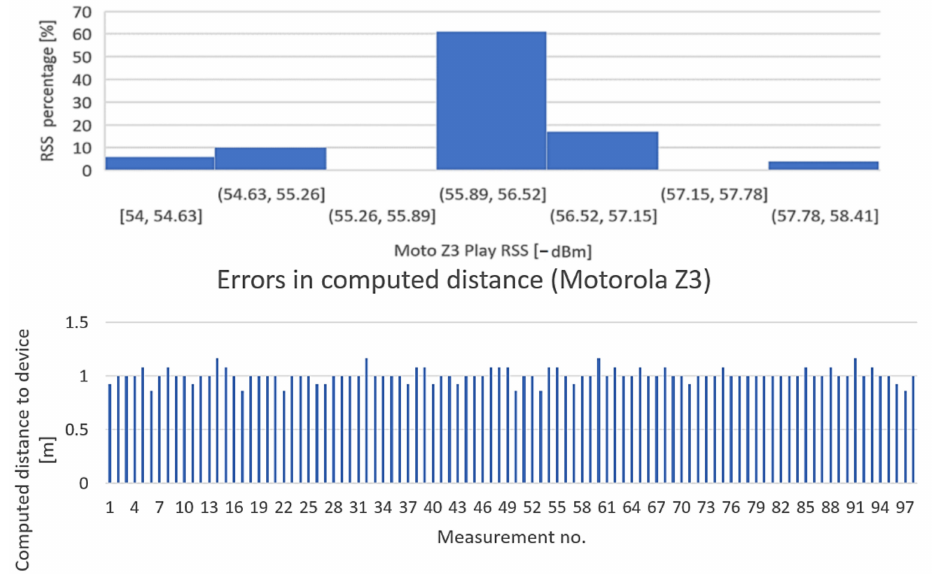
Figure 21. Variation in signal strength for fixed position of mobile station, LoS, d = 1 m. Equipment: Motorola Z3.